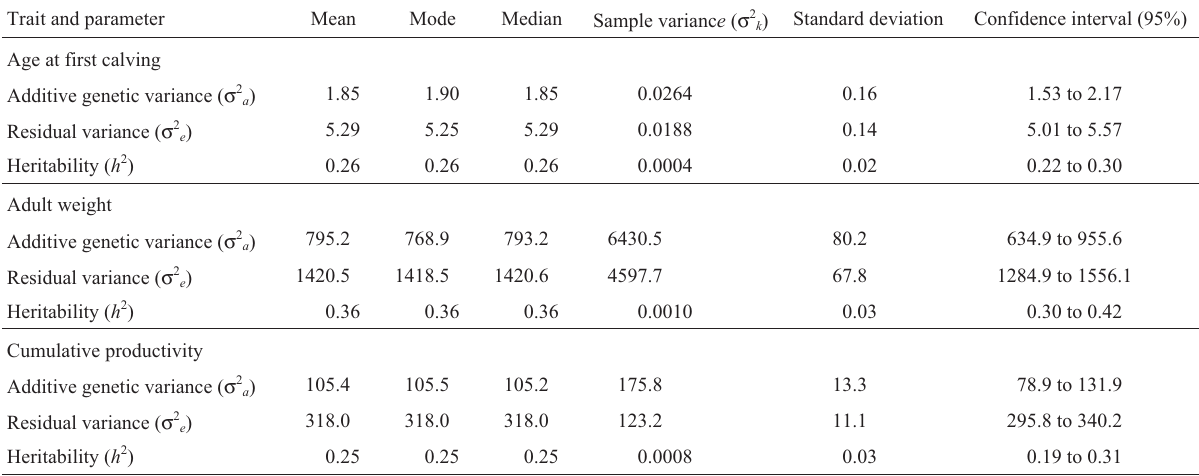
Table 2 - Descriptive statistics of variance components and heritabilities for age at first calving, adult weight and cumulative productivity obtained from single-trait analyses by Gibbs Sampling. Trait and parameter